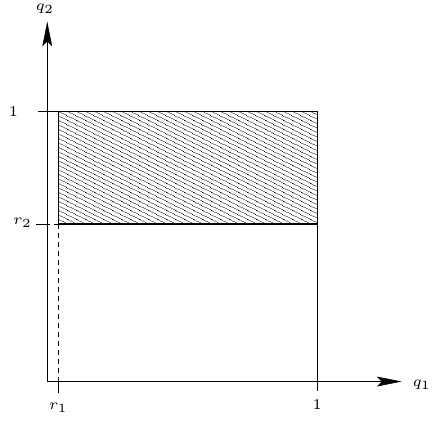
Figure 6. The region in which Ally-Ally is a Nash equilibrium when Player I makes a unilateral commitment to improved market performance.